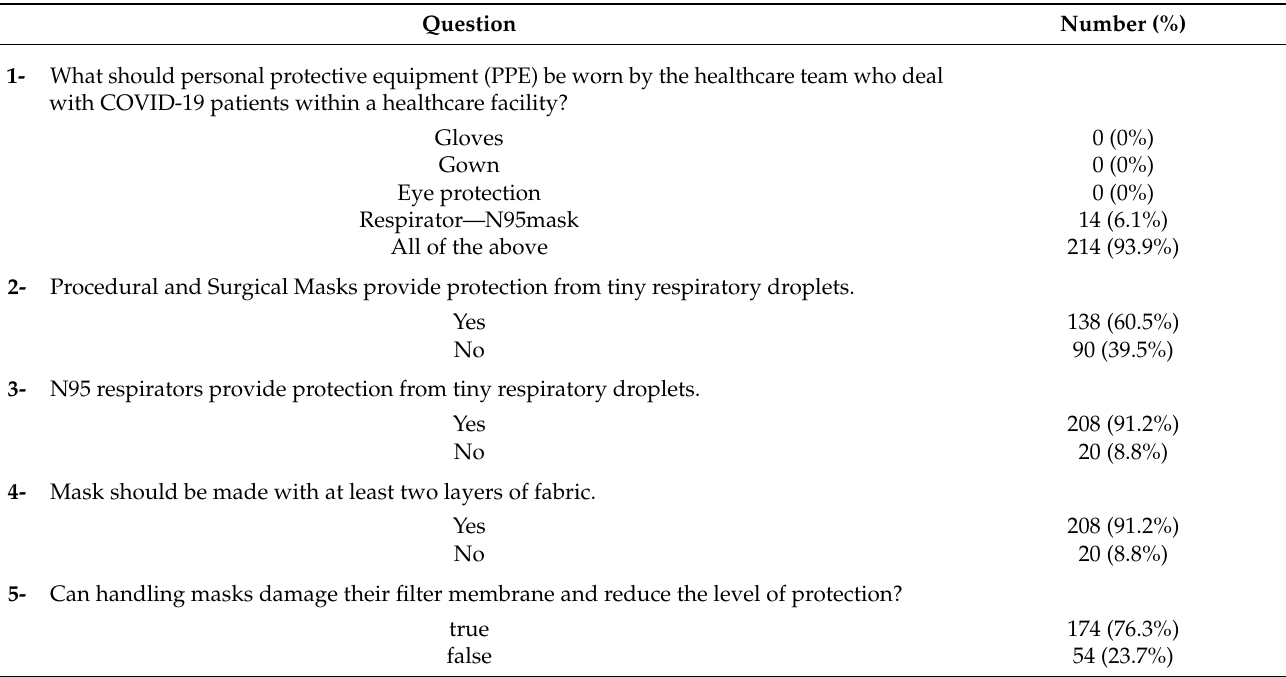
Table 4. Knowledge about face